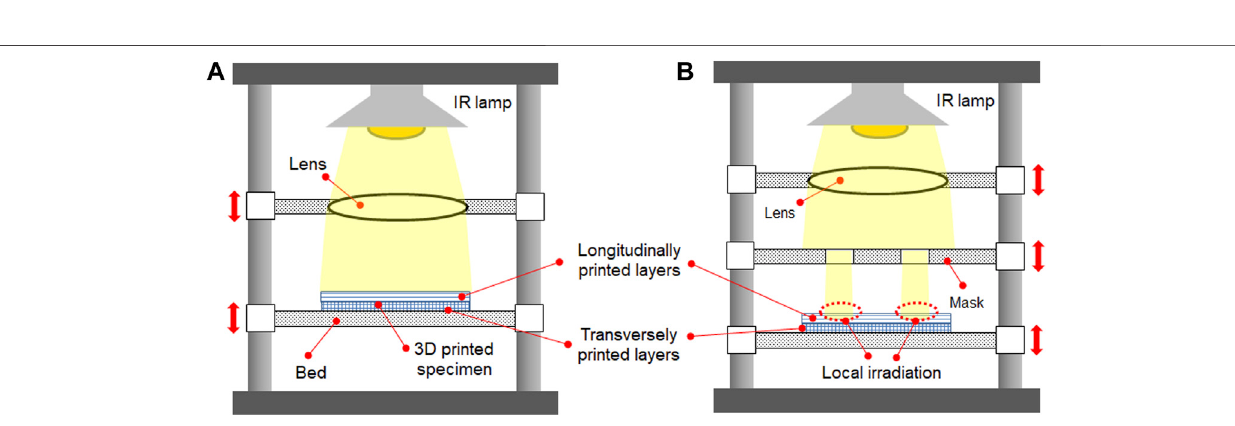
Frontiers in Materials |